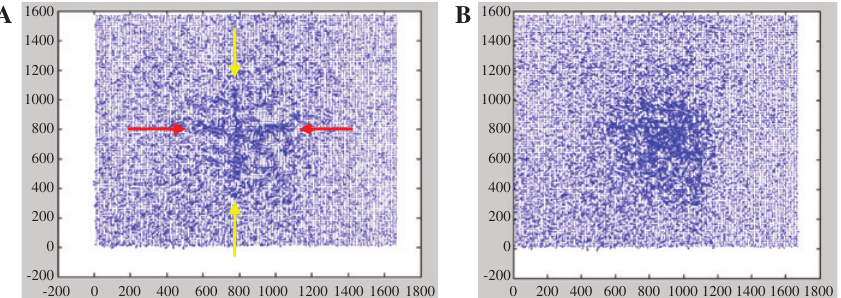
Figure 4 (A) MatPIV 1.6.1 software-QUIVER result (processing of the first and second images after switching off the soldering iron), (B) 2D-PIV software ver. 3.001-1.11-QUIVER result (processing of the first and second images after switching off the soldering